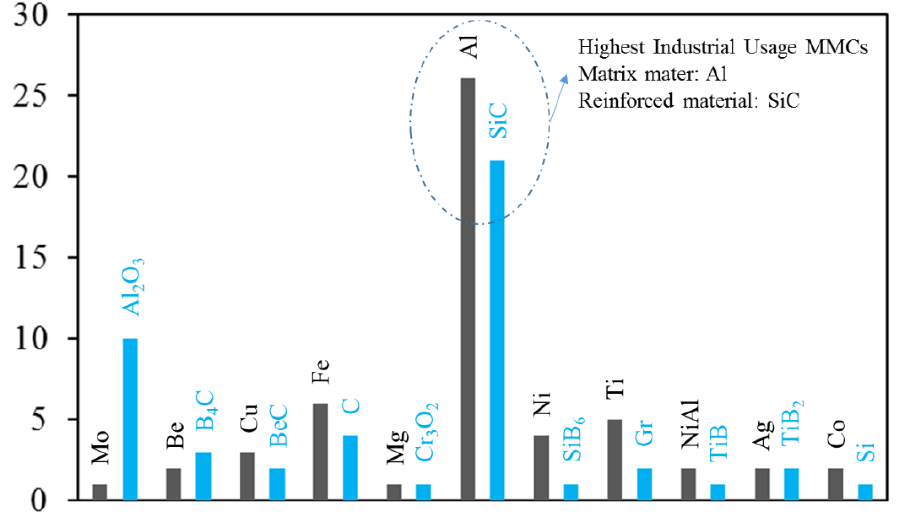
Figure 1. Core matrix and reinforced materials and their usage volume in MMCs.